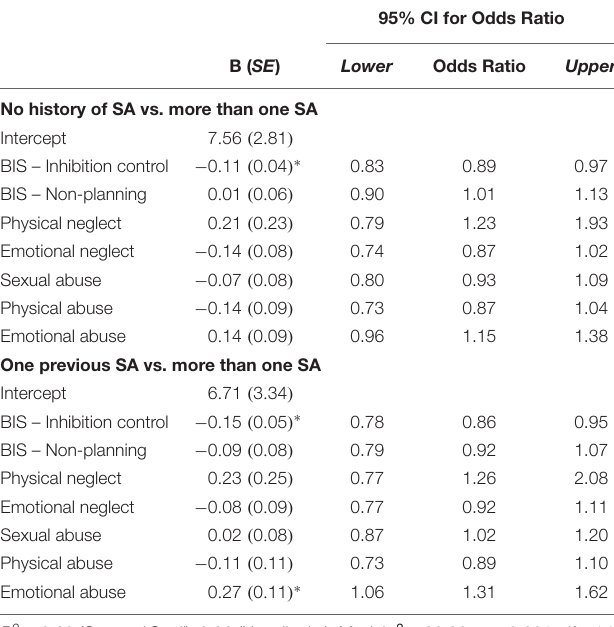
TABLE 4 | Multinomial logistic regression for history of suicide attempt.